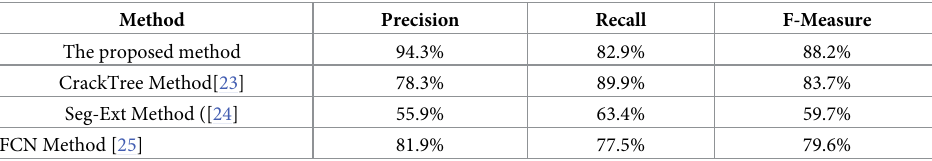
Table 2. Crack growth experiment results for three